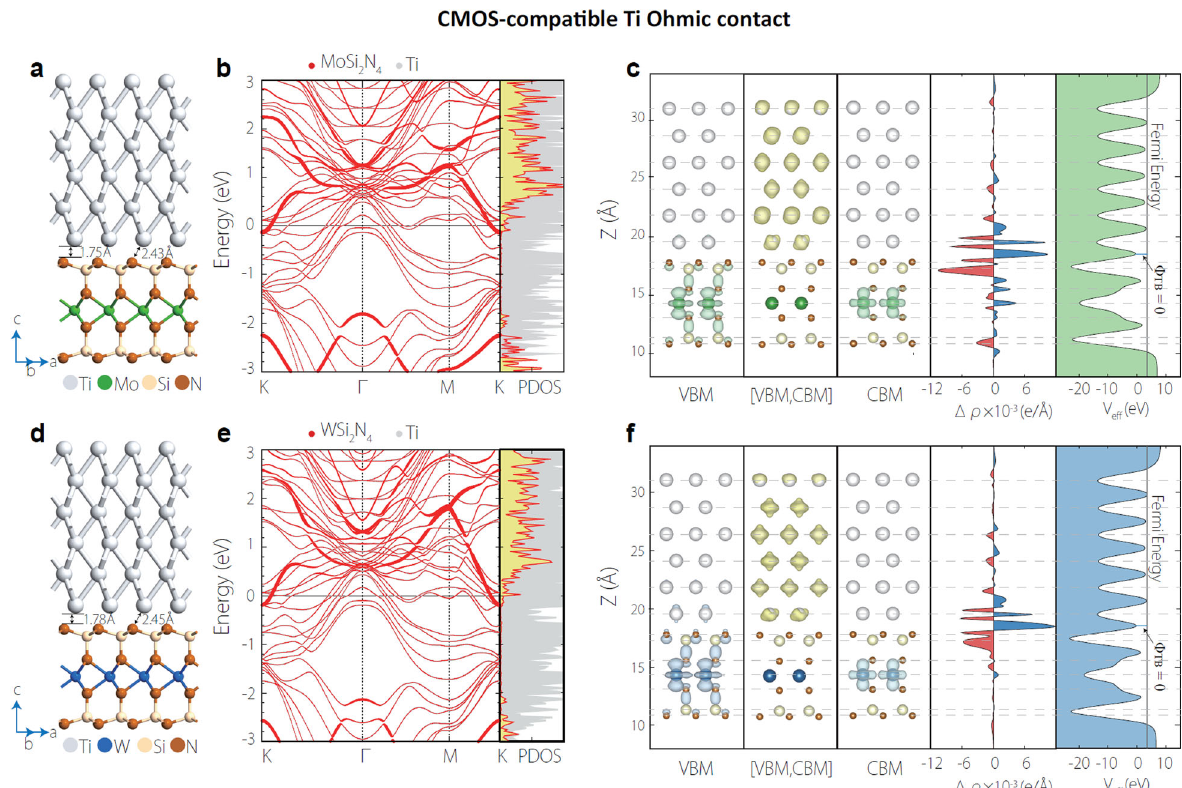
Fig. 3 Ohmic contacts of Ti/MoSi 2 N 4 and Ti/WSi 2 N 4 — structural and electronic properties. a The contact is composed of six layers of Ti atoms contacting the MoSi 2 N 4 monolayer. The interlayer distance is 1.75 Å and the minimum distance between Ti and N atoms is 2.43 Å . b The projected electronic band structure and the partial density of states of Ti/MoSi 2 N 4 contact. The panels in c from left to right, show the spatial charge density distribution of VBM states, mid-gap states between VBM and CBM, and the CBM states, the differential charge density, and the electrostatic potential pro fi le across the heterostructures. d – f Same as a , b , and c , respectively, for Ti/WSi 2 N 4 contact. The interlayer distance is 1.78 Å and the minimum distance between Ti and N atoms is 2.45 Å